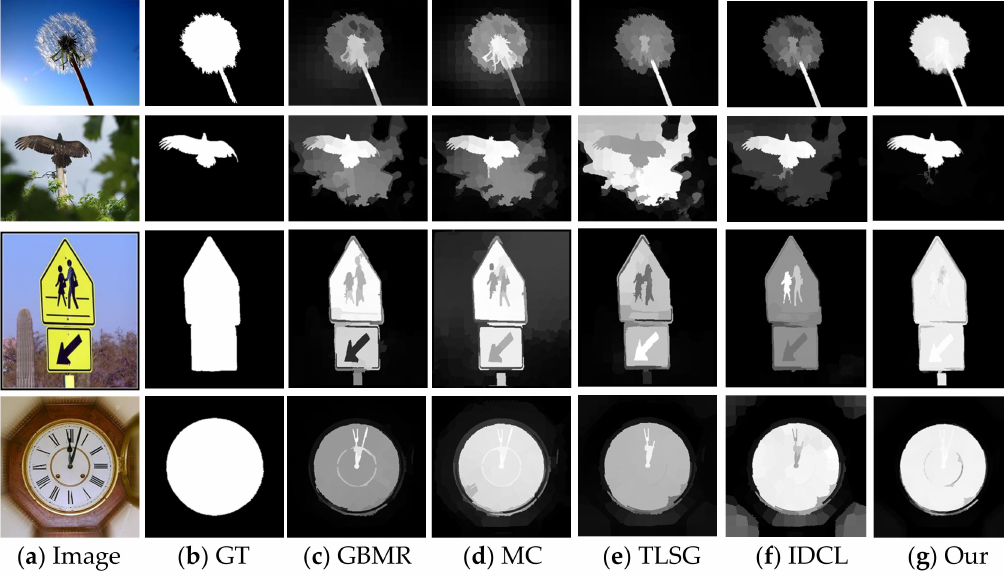
Figure 1. Visual comparisons of the diffusion-based methods with the 2-layer neighborhood graph (GBMR [23], MC [24], IDCL [9]), 2-layer sparse graph (TLSG [16]) and our